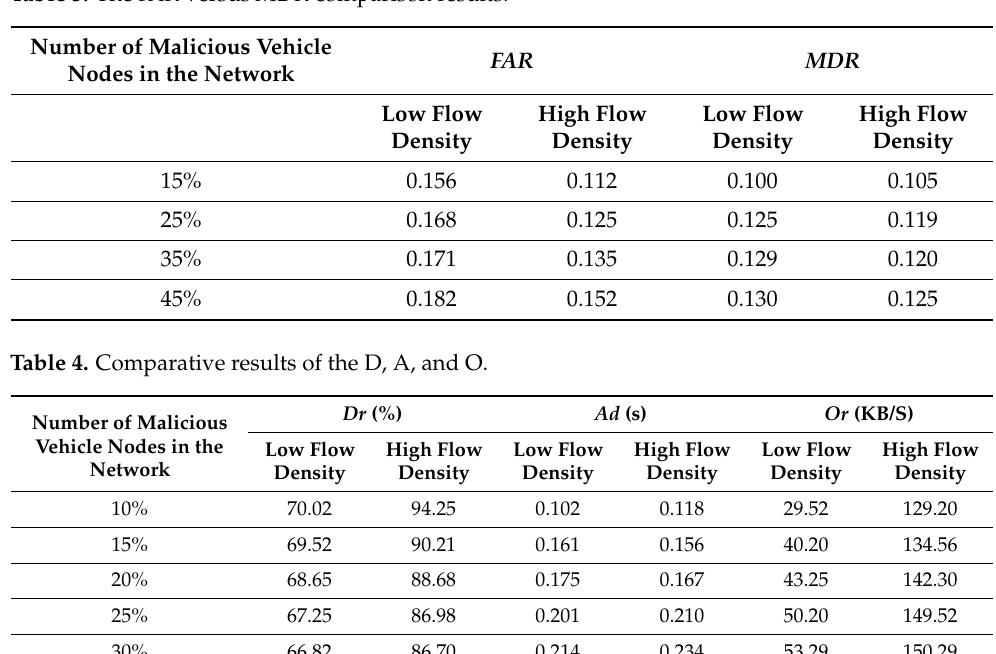
Table 3. The FAR versus MDR comparison results. Number of Malicious Vehicle Nodes in the Network